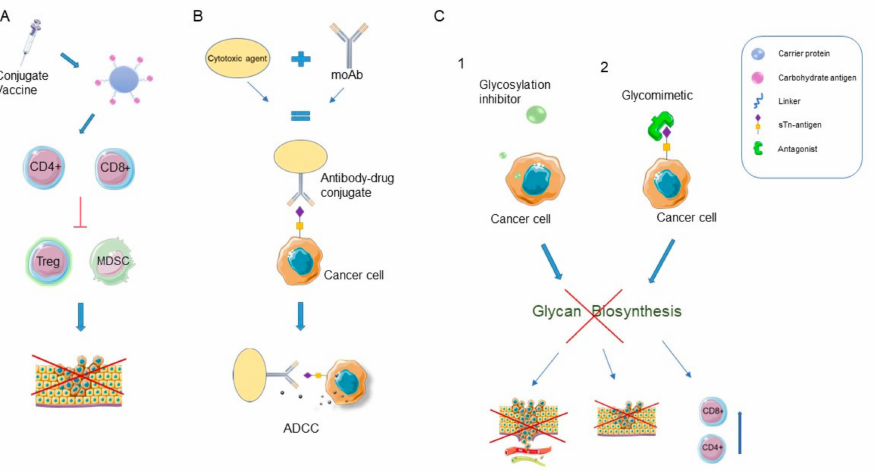
Figure 1. Glycan-based therapies. ( A ) Carbohydrate vaccine induces a cytotoxic T lymphocyte response and anti-tumor immunity by reducing the function of immunosuppressive cells (Treg and MDSC) and inhibits the proliferation of cancer cells. ( B ) Antibody drug conjugates (ADCs) are